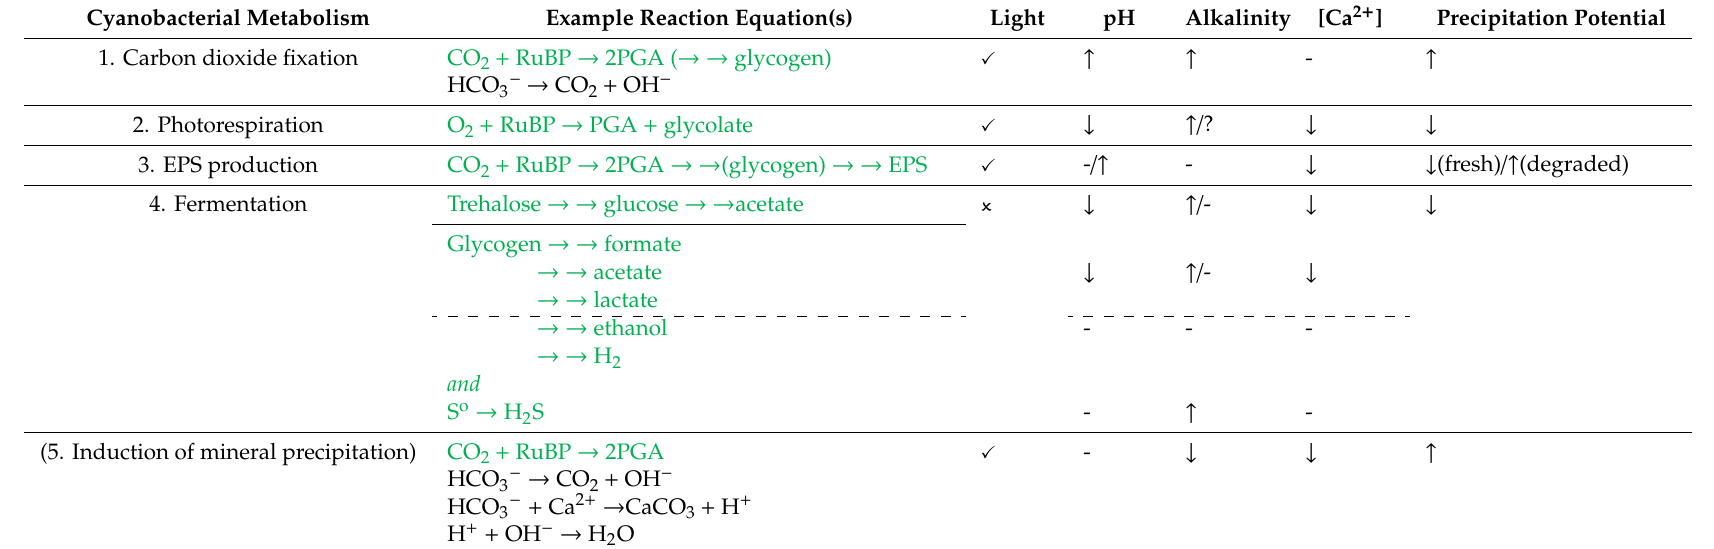
Green reaction equations indicate cyanobacterial metabolisms; equations in black indicate chemical reactions; RuBP = Ribulose 1,5-bisphosphate, PGA = phosphoglycerate (Calvin Cycle